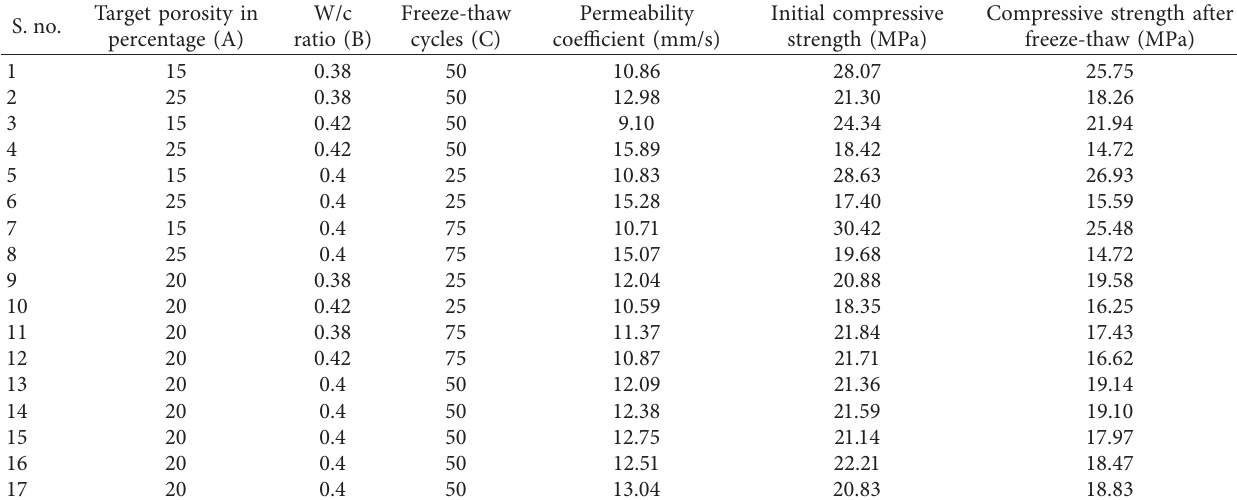
Table 10: Compressive test plan and results.